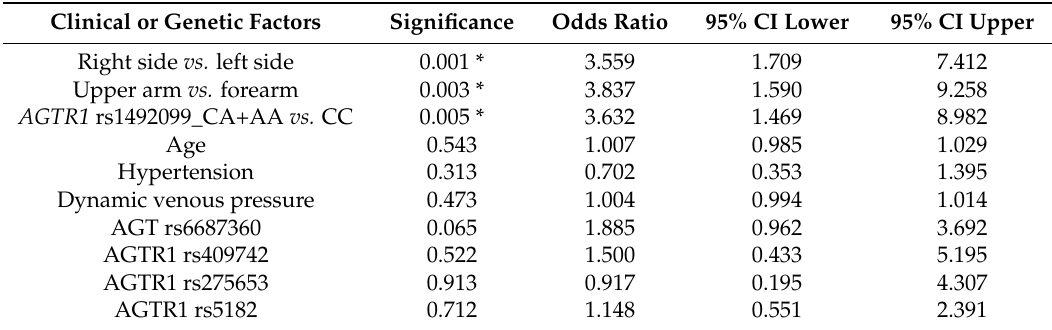
Table 6. Multivariate logistic regression model of factors associated with AVF malfunction in male HD patients. Clinical or Genetic Factors Significance Odds Ratio 95% CI Lower 95% CI Upper Right side vs. left side 0.001 * 3.559 Upper arm vs. forearm 0.003 * AGTR1 rs1492099_CA+AA vs.